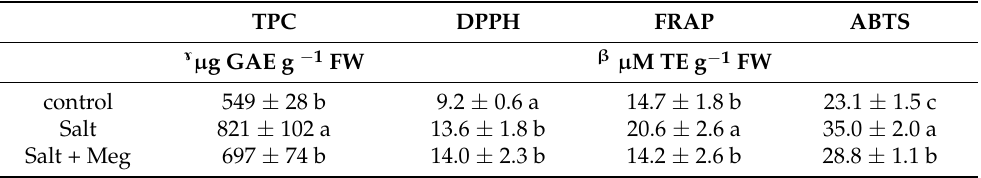
β µM TE g −1 sample: µM Trolox Equivalent for gram. ɤ µg GAE g −1 sample: µ g gallic acid equiva-